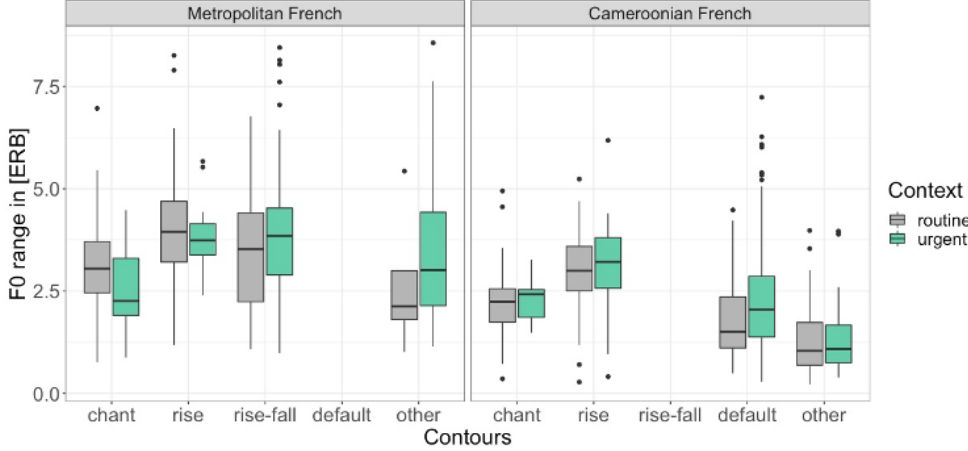
Figure 15. F0 range in the routine and urgent context across different calling melodies in MF and CF.